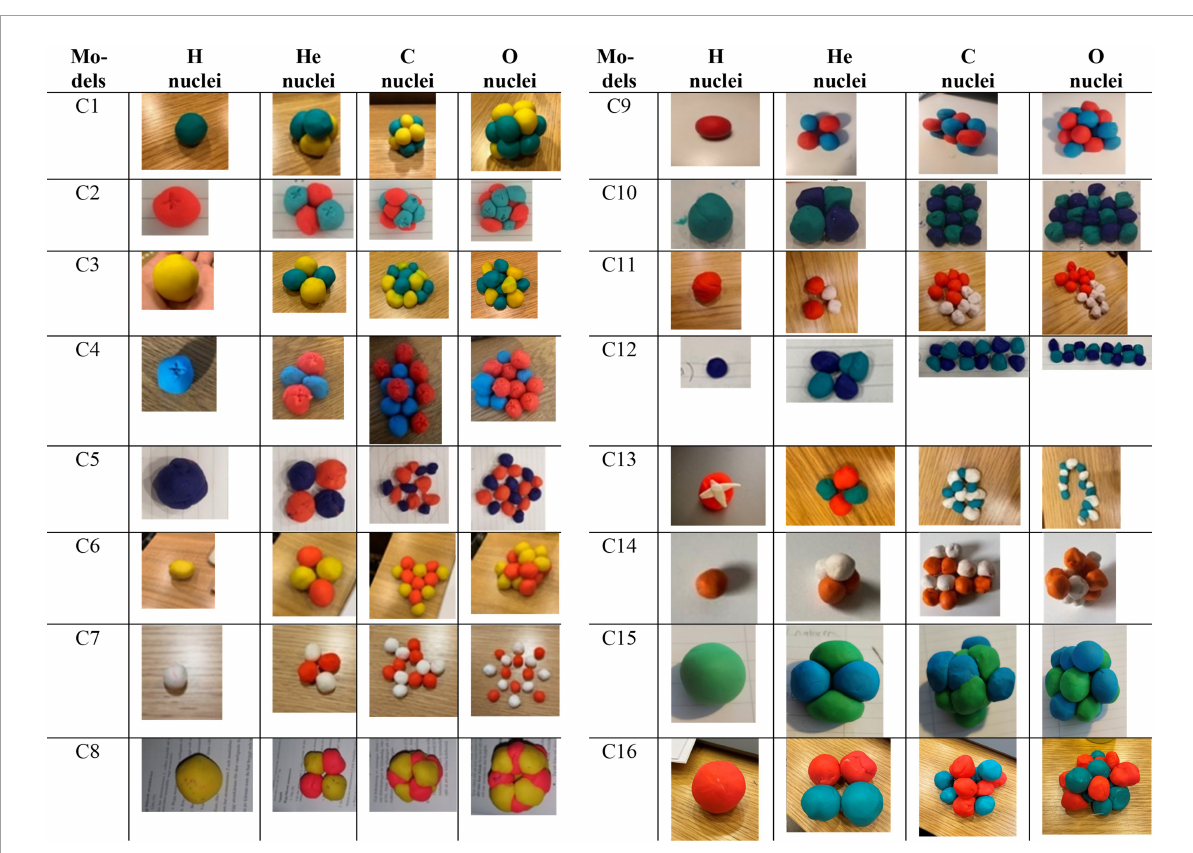
FIGURE2 Models with close resemblance to the teaching model regarding written explanations, a correct number of protons and neutrons in the playdough model, and mass was provided in a correct manner. Series of atomic nuclei in the order: Hydrogen (H), Helium (He), Carbon (C), and Oxygen (O). One student in each row (C1–C16) and the different versions of the nuclei are found in the